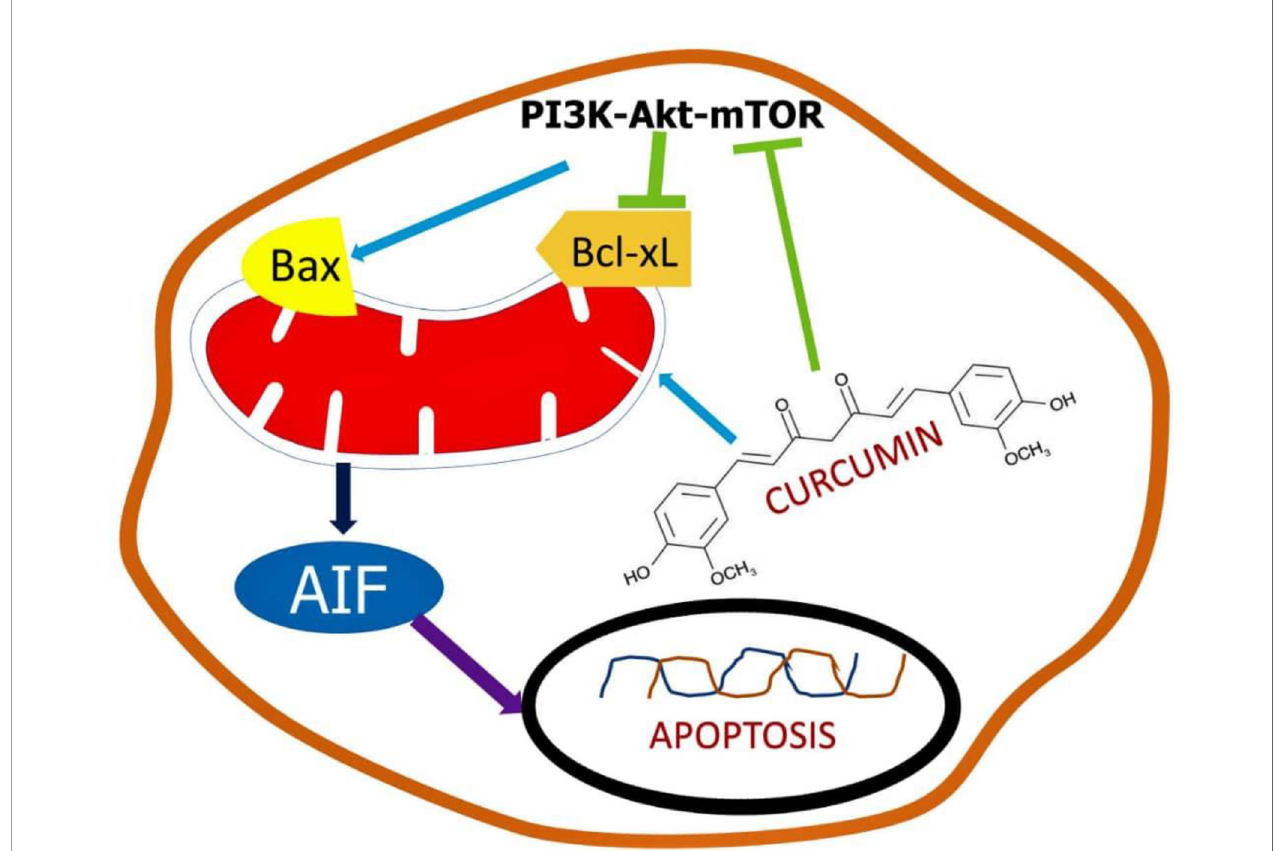
FIGURE 3 | Schematic representation of the mechanism of curcumin in stem